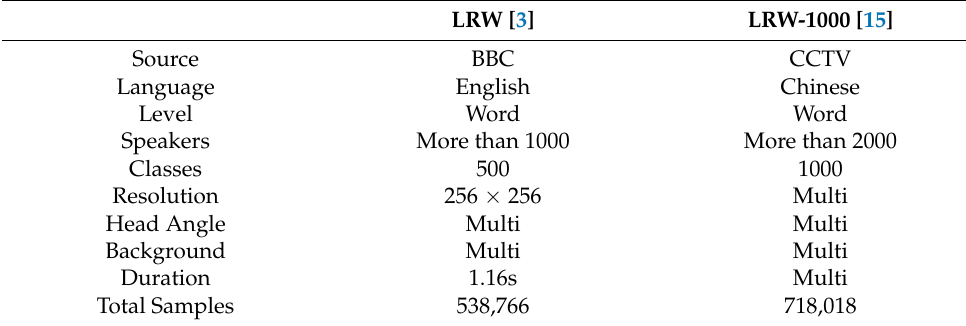
Table 2. Details of LRW and LRW-1000.